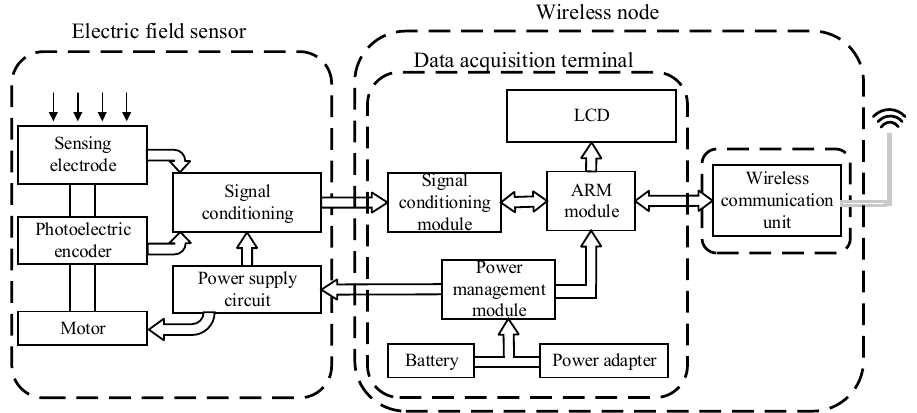
Figure 2. Schematic diagram of the wireless sensor node.